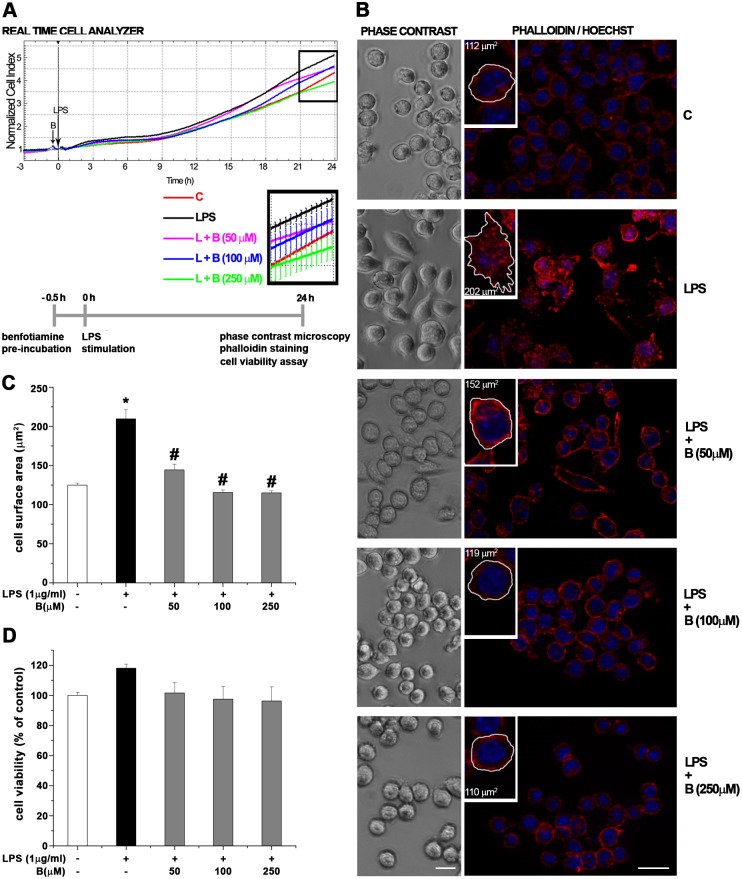
Functional characterization of benfotiamine effects in LPS-stimulated BV-2 microglia.(A) Real-time monitoring of BV-2 cell viability using xCELLigence RTCA analyzer. Representative graph showing the rate of proliferation in cells incubated in control medium (red line), medium with 1 μg/ml LPS (black line), or cells pretreated with benfotiamine, 50 μM (pink line), 100 μM (blue line) or 250 μM (green line) and then treated with LPS for 24 h. (B) Benfotiamine- induced alterations in cell morphology were analyzed using phase-contrast microscopy (left panels), whereas cell surface area was quantified by Phalloidin /Hoechst fluorescent staining (red/blue) microscopy (right panels), using AxioVisionRel 4.6 software. Insets: cell surface area was measured in five areas (138 × 104 μm2) per each cover-slip (n = 3) per experimental group in three independent experiments. (C) Bars present mean surface areas (± SEM) obtained from data presented in Fig. 1B. (D) Cell viability was assessed by crystal violet staining and results are displayed as percentage of control ± SEM (n = 3). *P < 0.05 control vs. LPS-induced BV-2 cells, # LPS vs. benfotiamine pretreated LPS activated BV-2 cells. Scale bar: 20 μm.